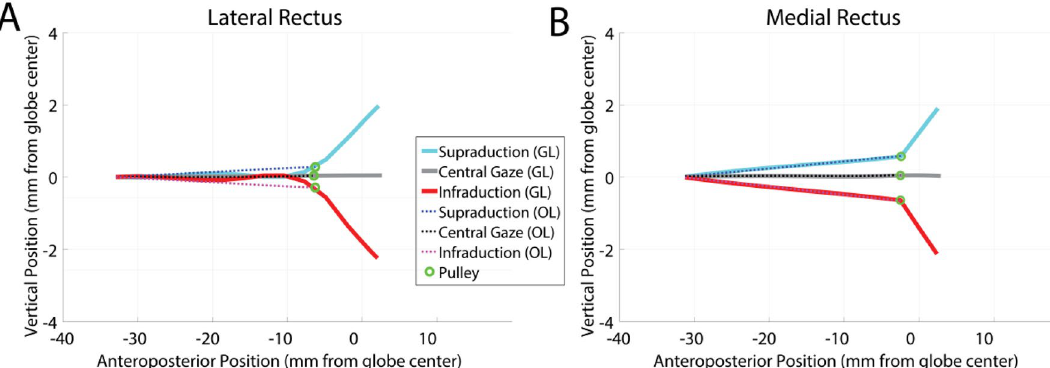
Figure 1. Sagittal plane visualization of simulated paths of the ( A ) lateral and ( B ) medial rectus muscle orbital and global layers in supraduction, central gaze, and infraduction. Muscle paths are inflected at the pulleys, but exhibit small transverse displacement within physiological range measured empirically by